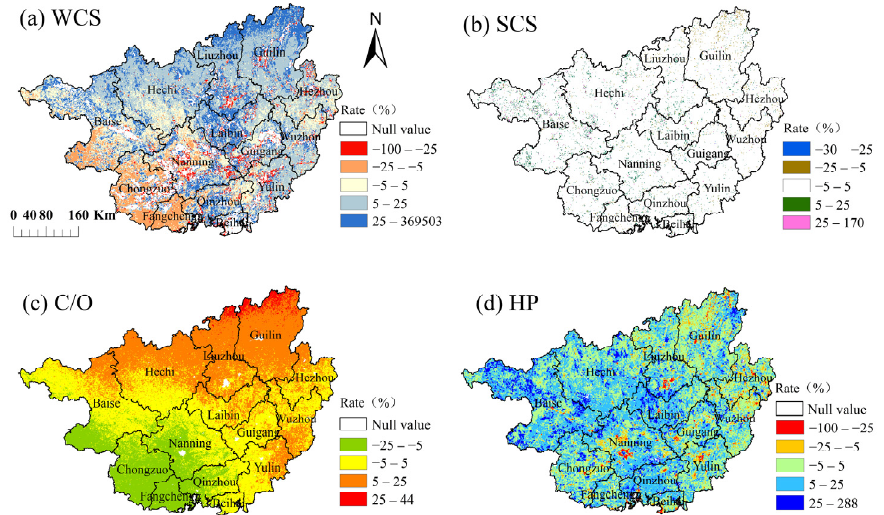
Figure 7. Distribution of ecosystem regulation services changes from 2005 to 2020.